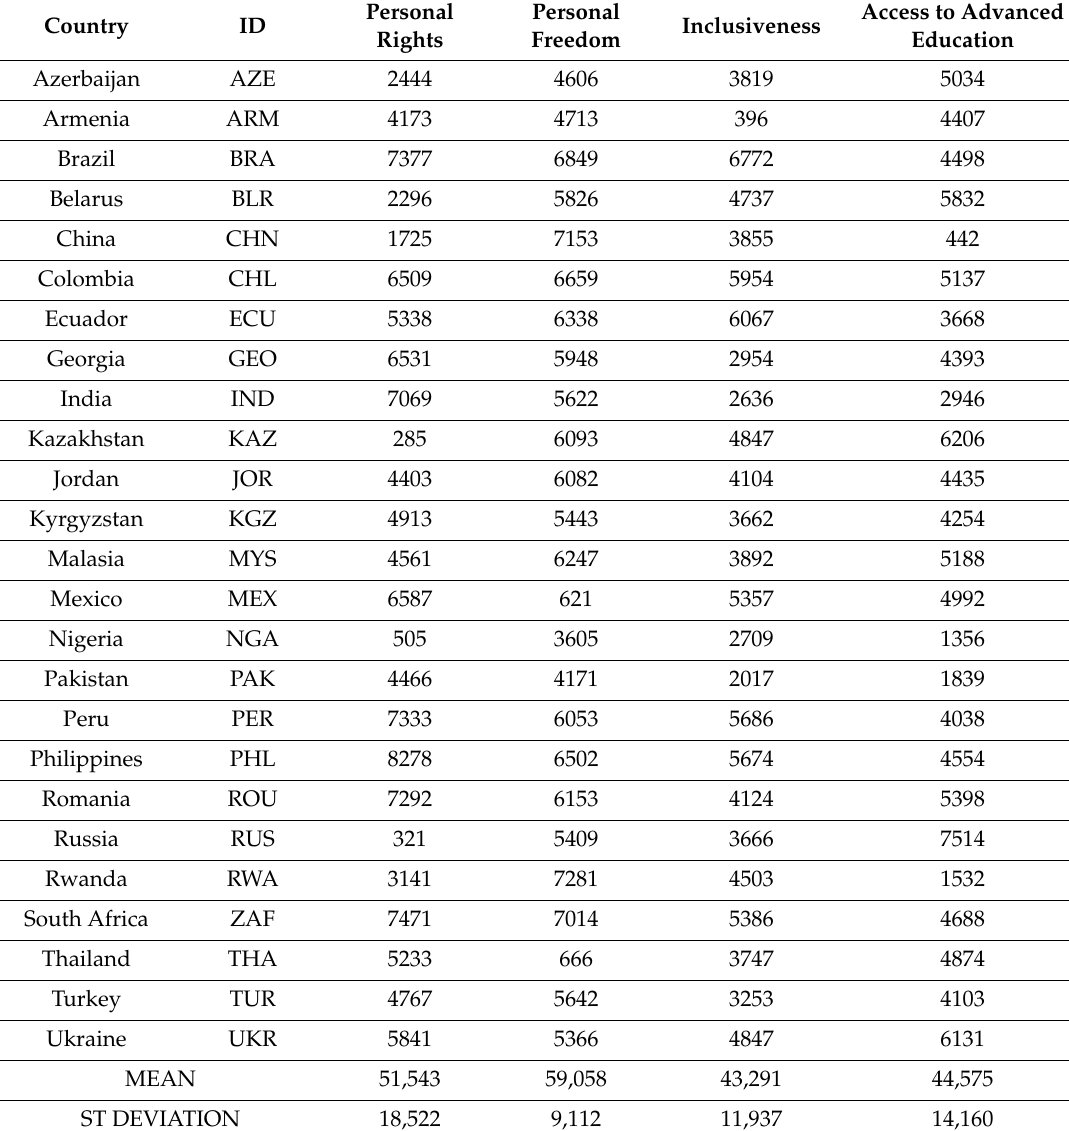
Table A3. Components of the Opportunity Index by